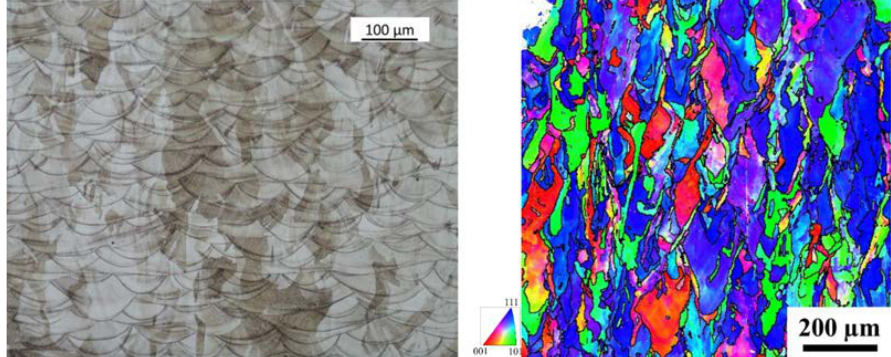
Figure 6. ( Left ) Micrograph of a region in Figure 5, showing the larger grains resulting from thermocapillary convection from the melt pool and heat dissipation; ( Right ) EBSD of as received 316L [19].